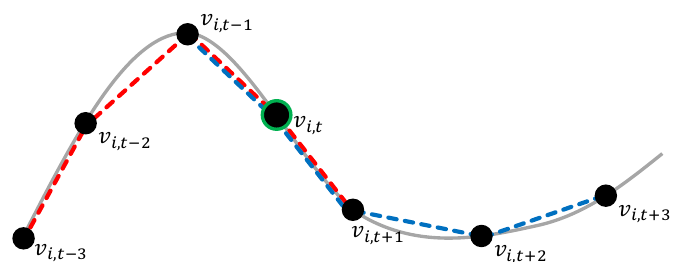
Figure 8. An illustration of the combined forward-backward prediction: To allow a robust estimation that exploits the motion characteristics, we use higher-order approximations of the central differences. Here, we predict the location of v i , t − 1 based on the previous and the following three frames. The red line connects the joint locations used for forward prediction (Equation (6)) and the blue lines connect the joint locations used for backward prediction (Equation